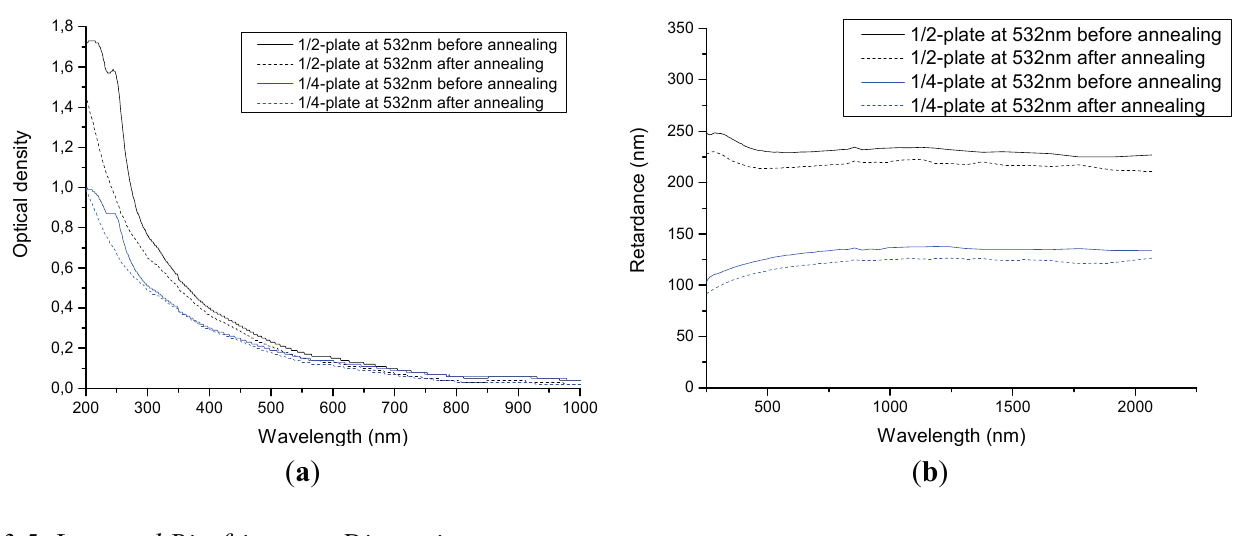
Figure 5. ( a ) Losses for a group of half (1/2) and quarter (1/4) waveplates samples. The full line are for the waveplates without any further treatment and the dotted lines are after annealing the waveplates at 600 °C for 2 h. ( b ) Spectral retardance dependence before and after annealing measured with the ellipsometer. The target retardance values were a half and a quarter of 532